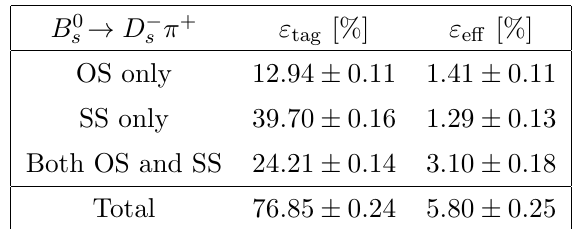
Table 2 . Performances of the (cid:13)avour tagging for B 0 only and both OS and SS